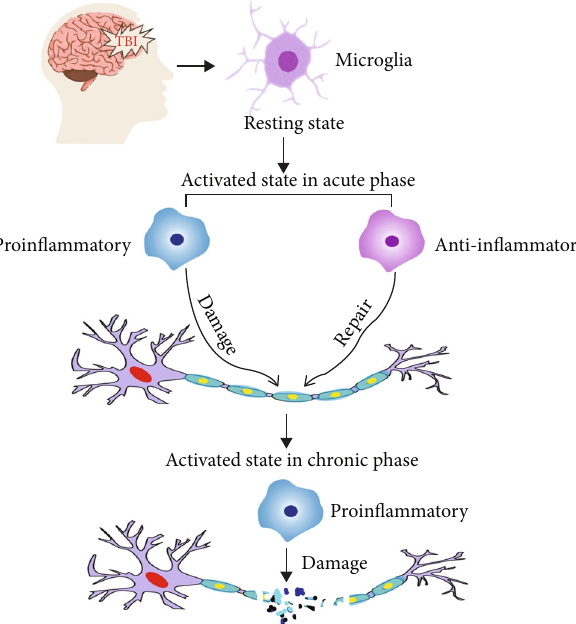
Figure 1: Microglia and TAI: traumatic brain injury will activate microglia rapidly, and microglia will transform from the resting state to the activated state. In the acute phase, activated microglia include proin fl ammatory and anti-in fl ammatory phenotypes which will play a role in axonal damage and repair, respectively. While in the chronic phase, activated microglia are mainly proin fl ammatory and will take part in the long-term process of axonal injury after